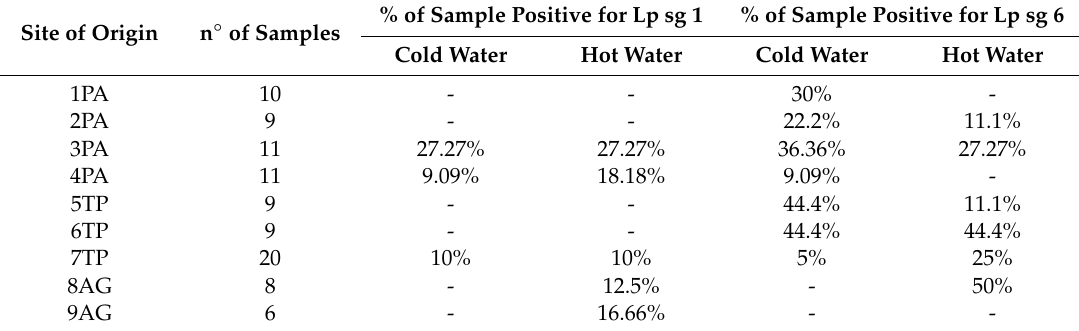
Table 2. Distribution of Legionella pneumophila (Lp) serogroup (sg) 1 and sg 6 in water samples analyzed before the cluster. % of Sample Positive for Lp sg 1 % of Sample Positive for Lp sg Site of Origin n ◦ of Samples